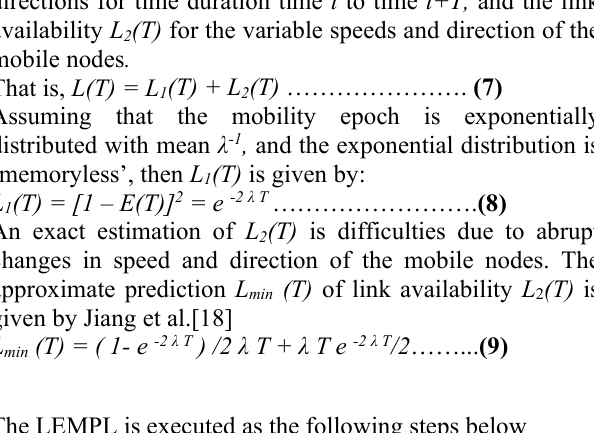
Table 1. Network